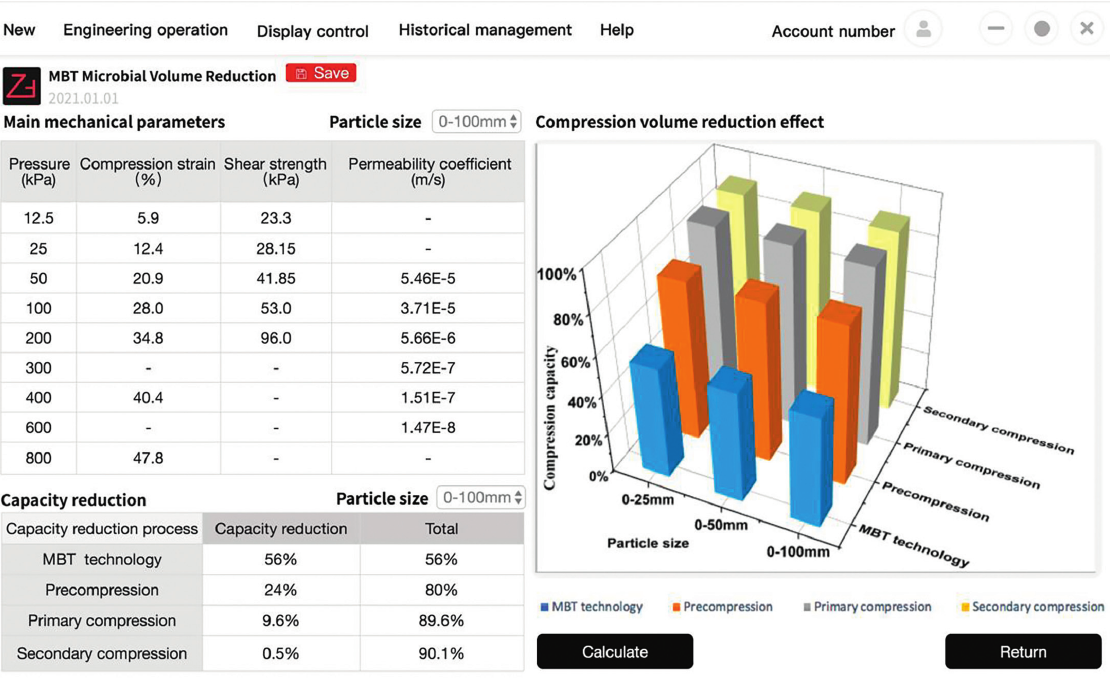
Figure 5: MBT microbial volume